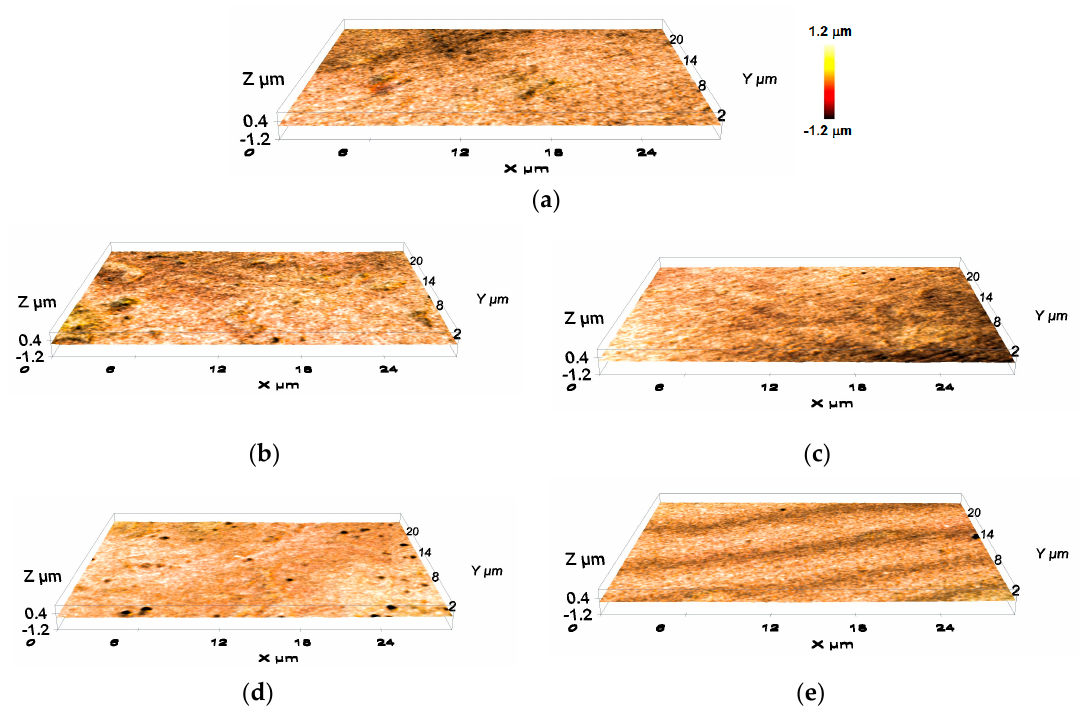
Figure 11. Surface topographies of the PU films: ( a ) untreated; and plasma treated (180 s) in: ( b ) air, ( c ) O 2 , ( d ) N 2 , ( e ) Ar.